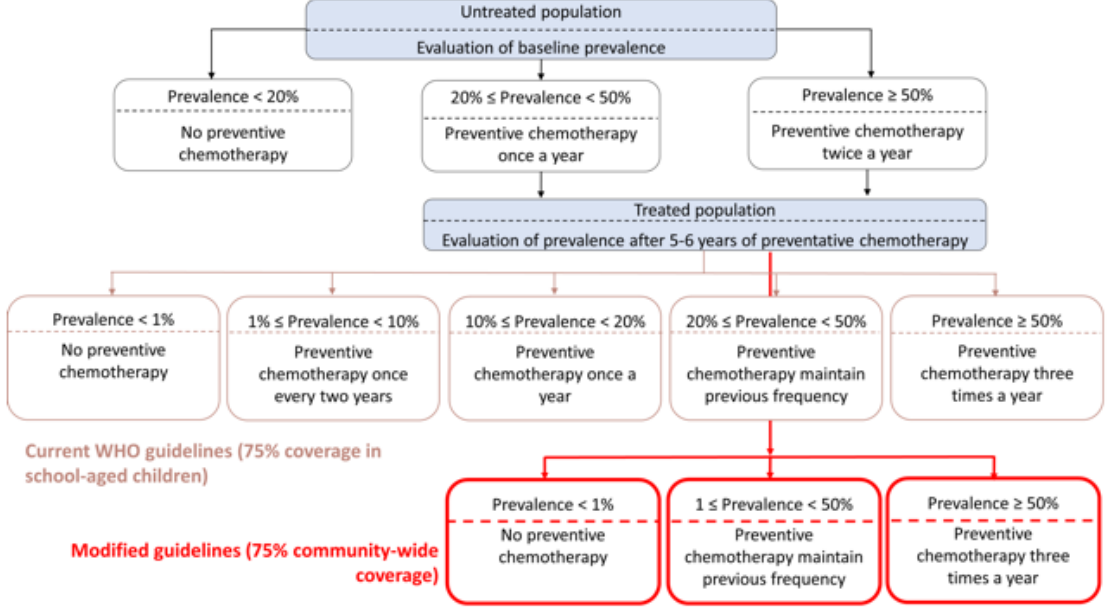
Figure 1. World Health Organization (WHO) decision tree showing the current WHO guidelines to achieve morbidity control in school-aged children (SAC) using 75% coverage in SAC (black and orange boxes). The bright red boxes represent the modified guidelines assuming 75% community-wide coverage (pre-SAC, SAC, and adults to replace the middle row of boxes that represent the current guidelines. This figure has been adapted from Figure 1 in 5 under a CC-BY 4.0